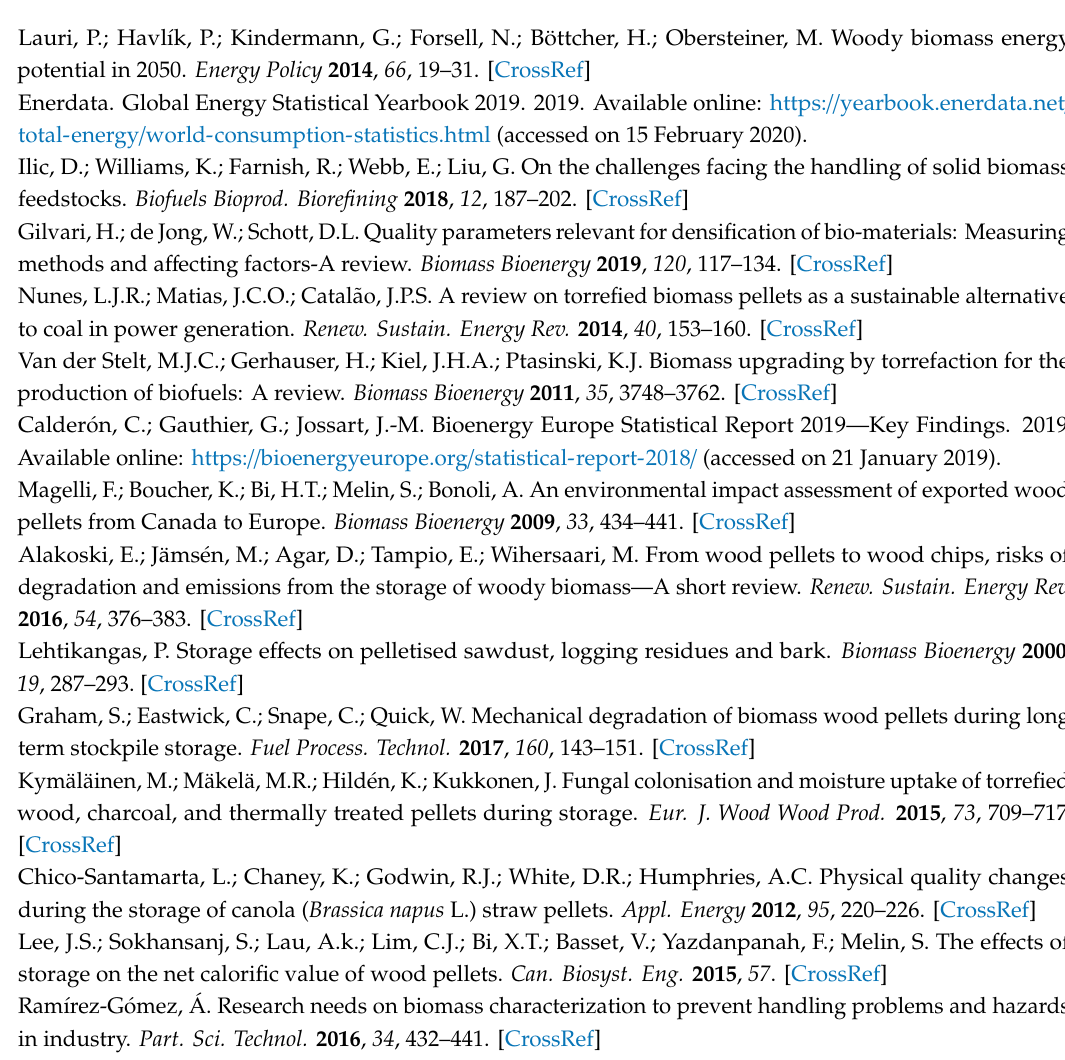
Figure S1: RH data at the T5_RH86, Figure S2: Moisture uptake at 20 ◦ C. Experimental results versus Oswin model for (a) brown and (b) white